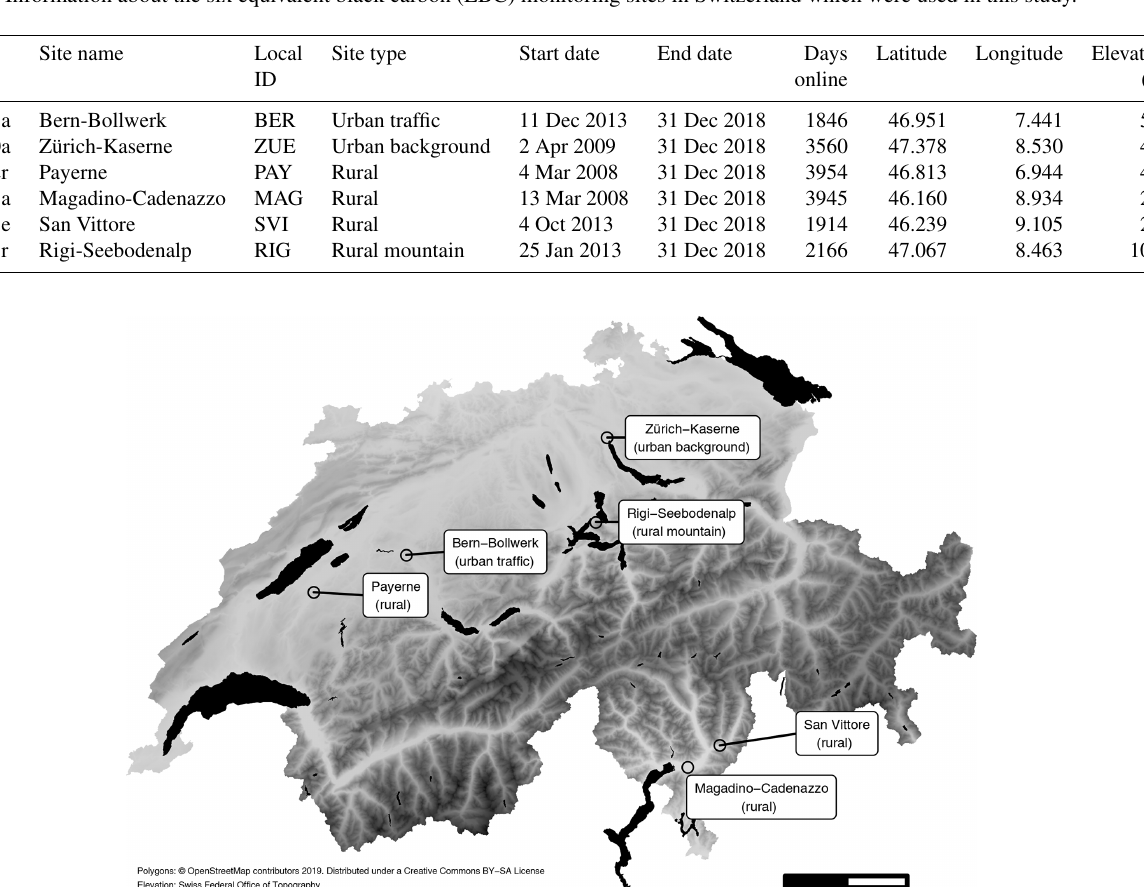
Table 1. Information about the six equivalent black carbon (EBC) monitoring sites in Switzerland which were used in this study.